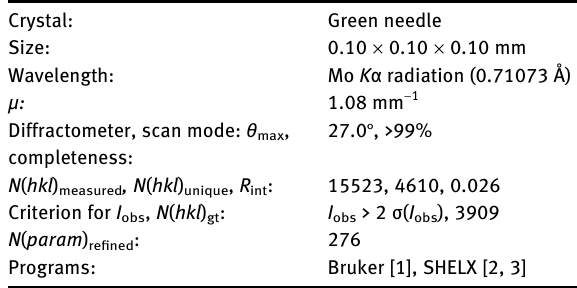
Table  : Data collection and